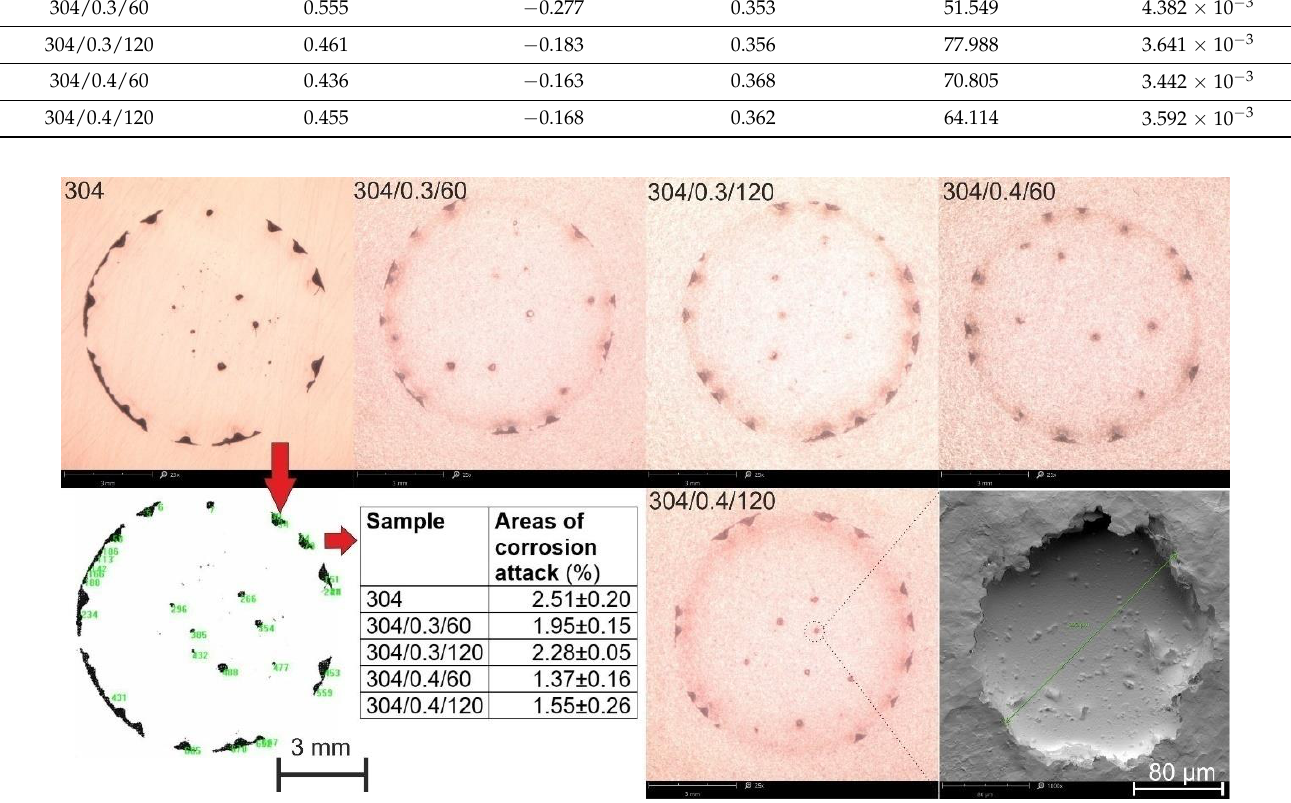
Figure 7. Micrographs of the surface after the potentiodynamic polarization testing in the 3.5% NaCl solution with visible areas of corrosion attack (dark areas).